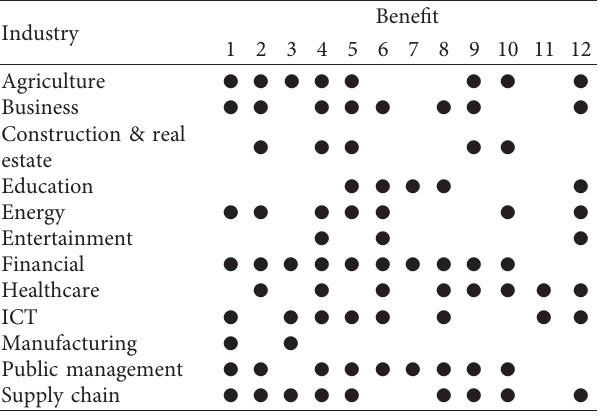
Table 6: Comparison of smart contract benefits in different industries.